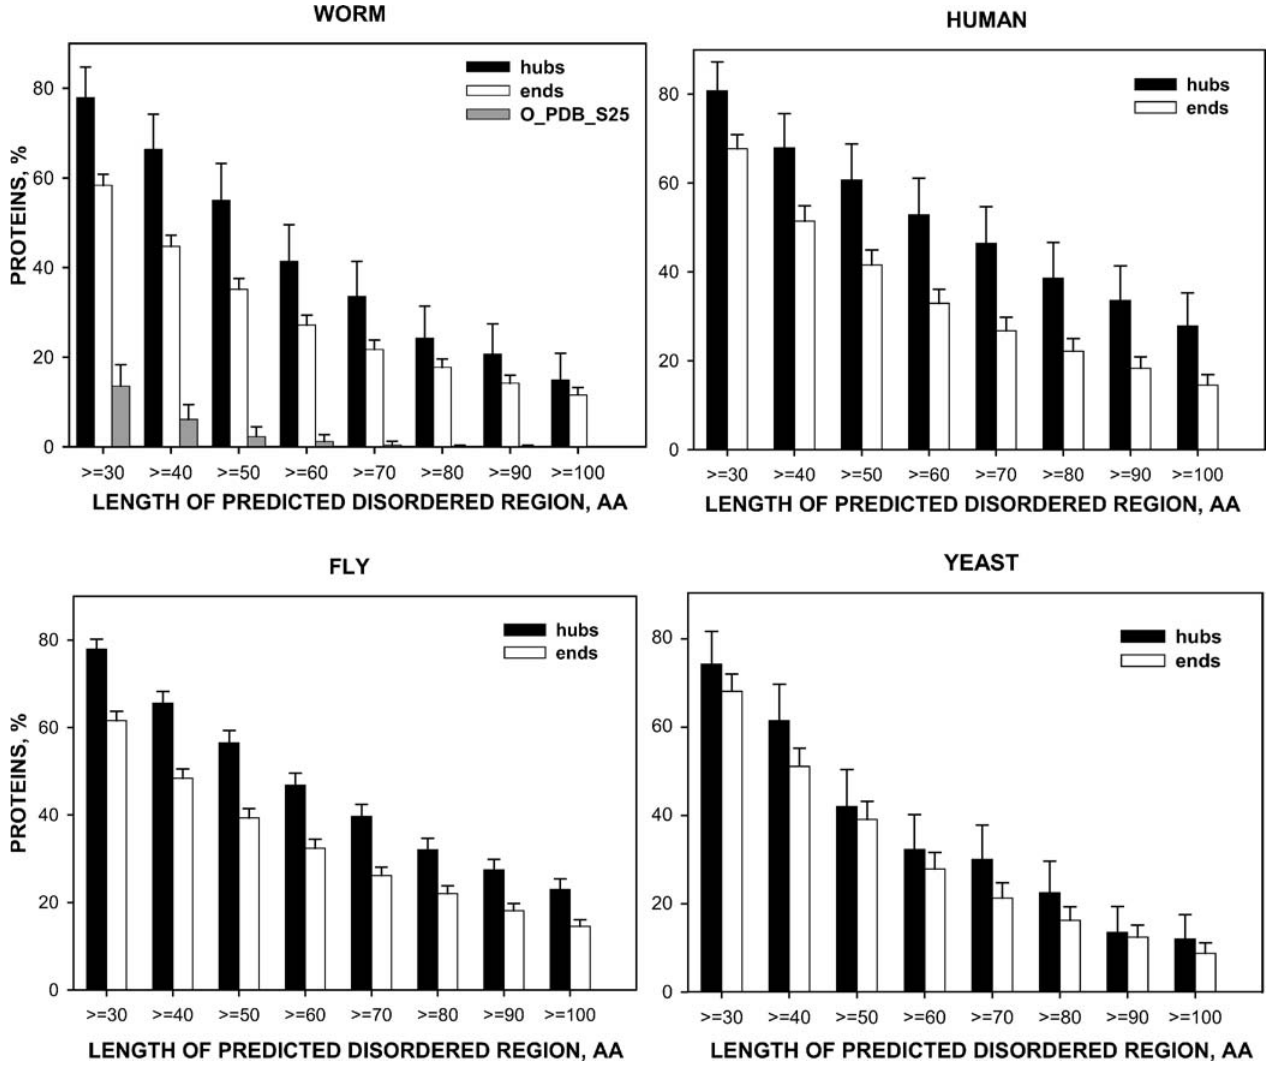
Figure 1. The Percentages of Hub and End Proteins with (cid:1) 30 to (cid:1) 100 Consecutive Residues Predicted to Be Disordered 95% confidence intervals were calculated using normal test for two binomial proportions. DOI: 10.1371/journal.pcbi.0020100.g001